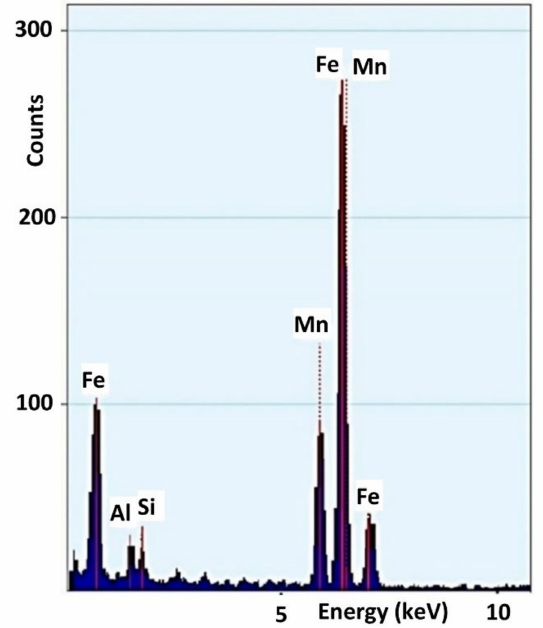
Figure 1. Chemical composition of the examined high manganese steel as determined by TEM/EDX